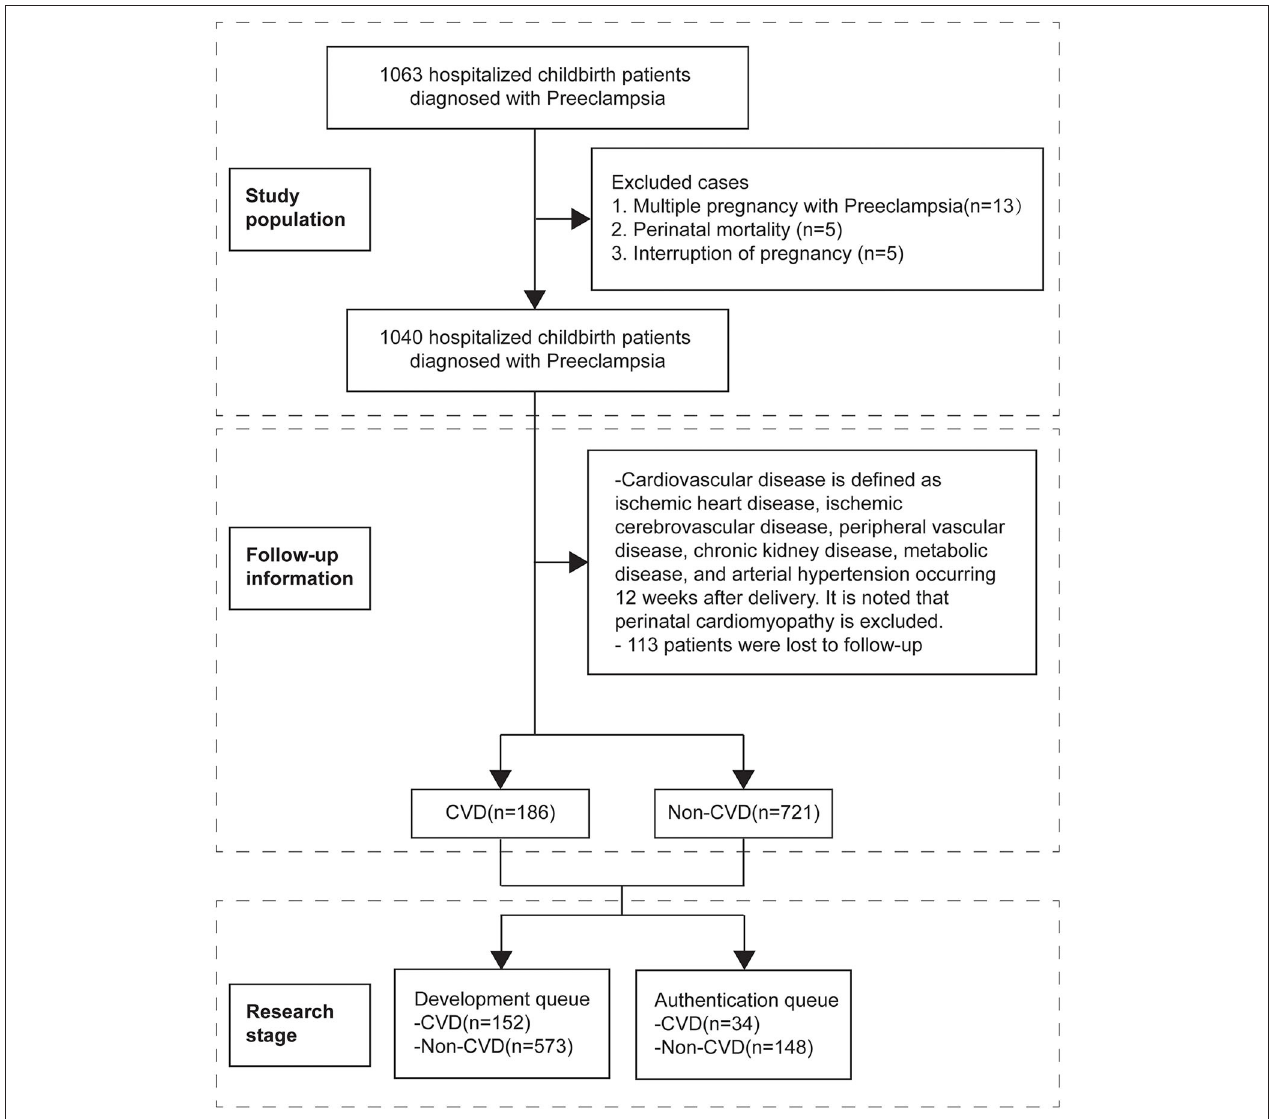
FIGURE 1 | Study flow. CVD, Cardiovascular